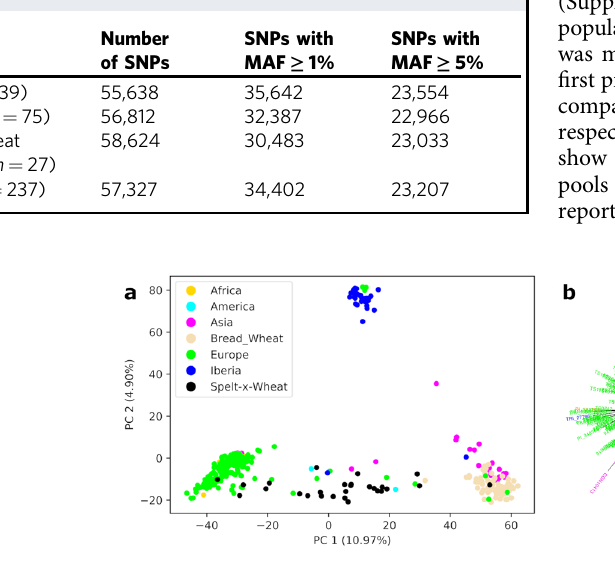
Table 1 Number of SNPs across different sample groups.